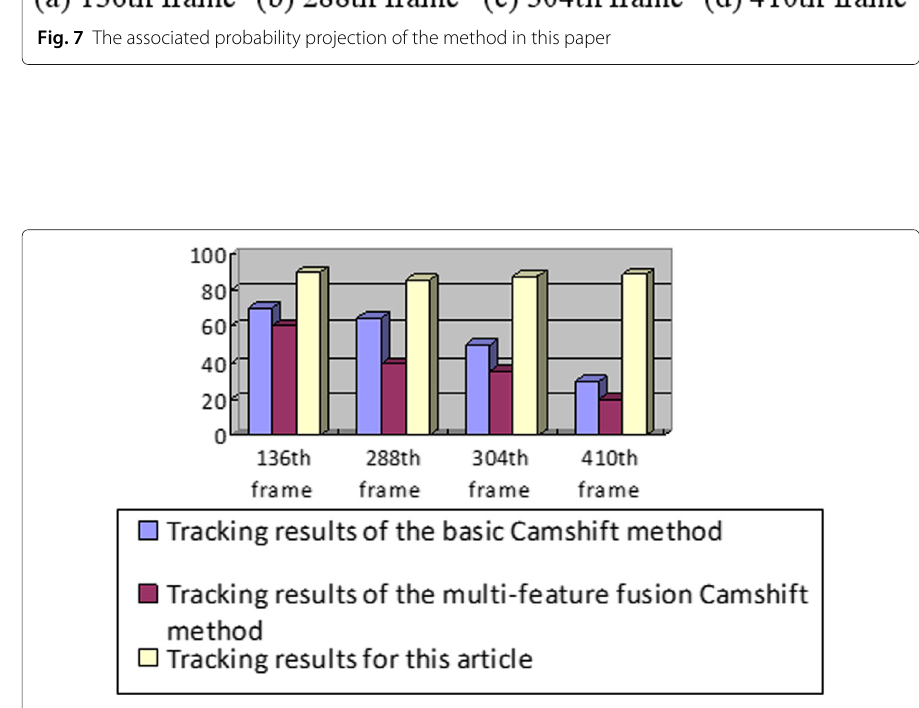
Fig. 8 The average overlap rate of the tracking targets for the three methods